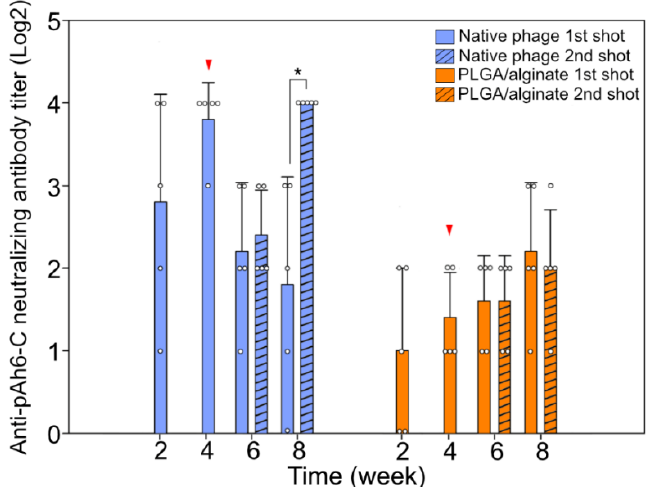
Figure 4. Antibody-mediated humoral immunity against bacteriophage administration (mean ± SEM, n = 5). Second administration was performed 4 weeks after the first administration (indicated by the red arrow). Blue and orange bars represent native and polylactic-co-glycolic acid (PLGA)/alginate-encapsulated bacteriophage administered groups, respectively. Bars without and with stripes represent single (first)- or boost (second)-administered groups, respectively. Asterisk (*) indicates statistical significance.